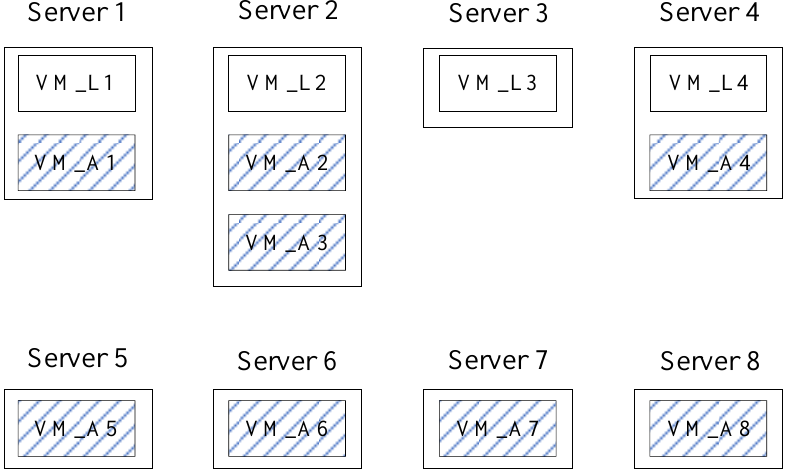
Figure 1. An example to explain Coverage and CVR.